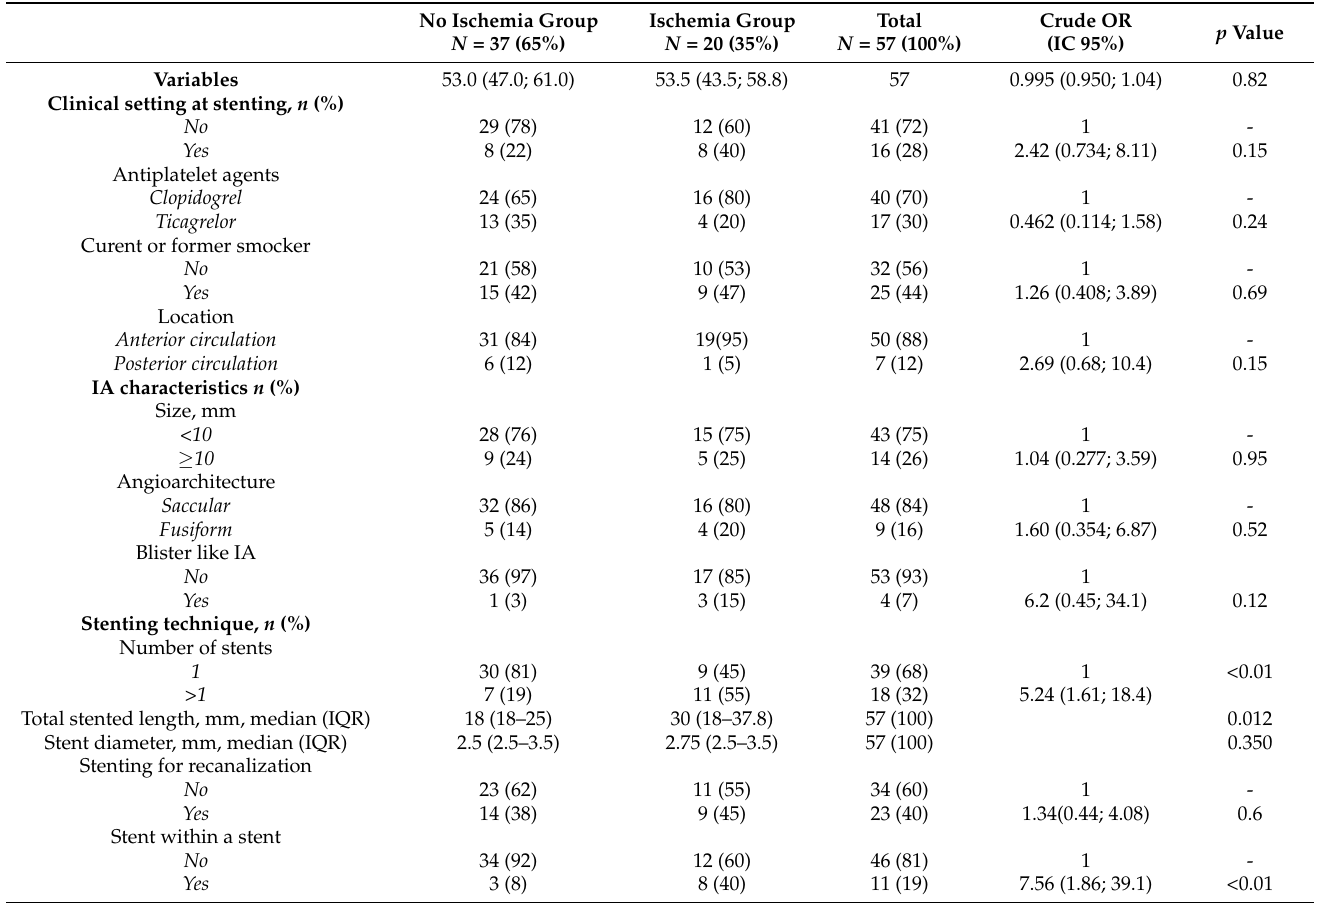
Table 4. Univariate analysis to identify factors associated with ischemia during